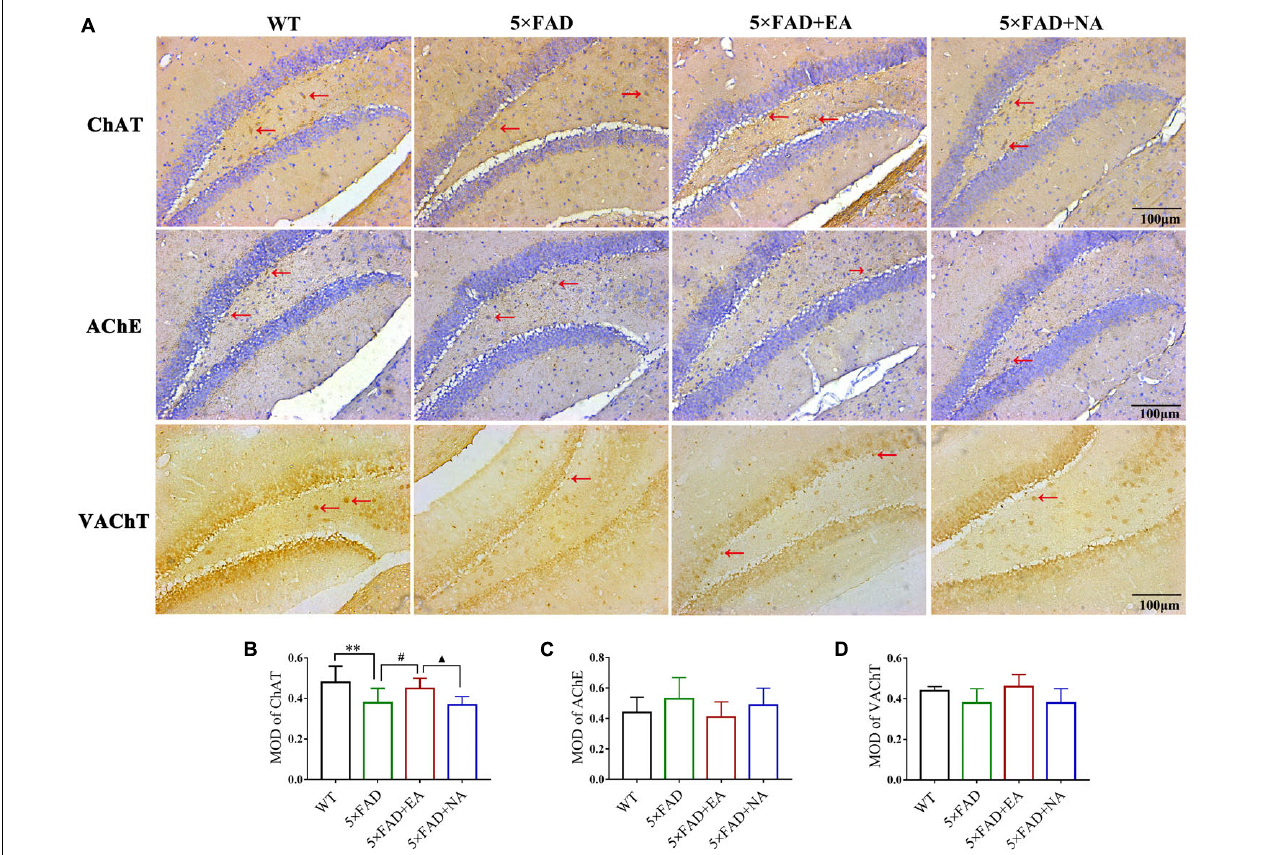
FIGURE 7 | Electro-acupuncture (EA) treatment regulates cholinergic biomarkers of DG by immunohistochemistry. ChAT and AChE express in the cytoplasm and nerve fibers (brown), and the nuclei are stained with hematoxylin (blue). VAChT expression is granular (brown), without hematoxylin staining of the nuclei. (A) Representative 200 × photomicrographs of ChAT (Top), AChE (Middle), and VAChT (Bottom) expression. (B–D) Statistical results of MOD of ChAT, AChE and VAChT in DG. Red arrows indicate positive protein expression, scale bar = 100 µ m. Data are represented as mean ± SD, n = 4/group (* p < 0.05 and ** p < 0.01 vs WT group; # p < 0.05 vs 5 × FAD group; (cid:78) p < 0.05 vs 5 × FAD + EA group). ChAT, choline acetyltransferase; AChE, enzyme acetylcholinesterase; VAChT, vesicular acetylcholine transporter; MOD, mean optical density.